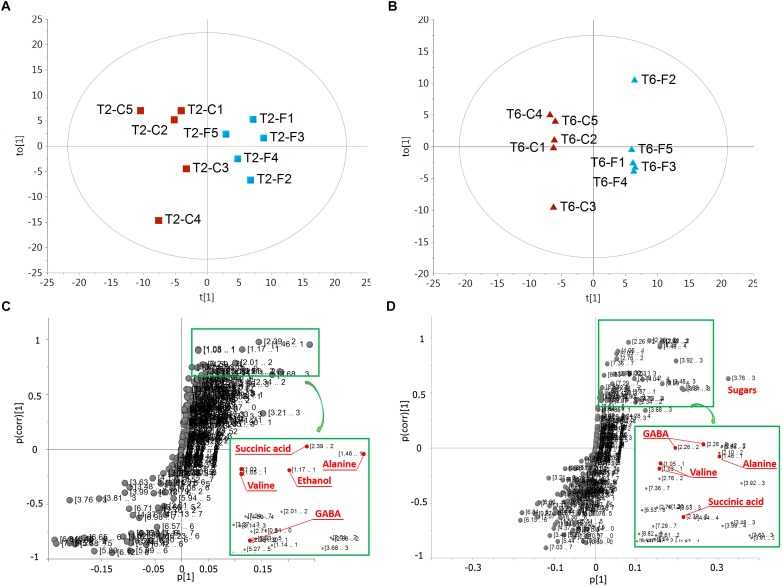
Scores (A,B) and corresponding S-plot (C,D) of orthogonal partial least-squares-discriminant analysis (OPLS-DA) on 1H-NMR spectra for extracts of control (C) and flooded (F) samples at the T2 (A,C, R2Y = 0.87, Q2Y = 0.77) and T6 (B,D, R2Y = 0.99, Q2Y = 0.89) time point, respectively. Square insets in the S-plots on the bottom right highlight the metabolites mainly contributing to the separation of flooded samples.